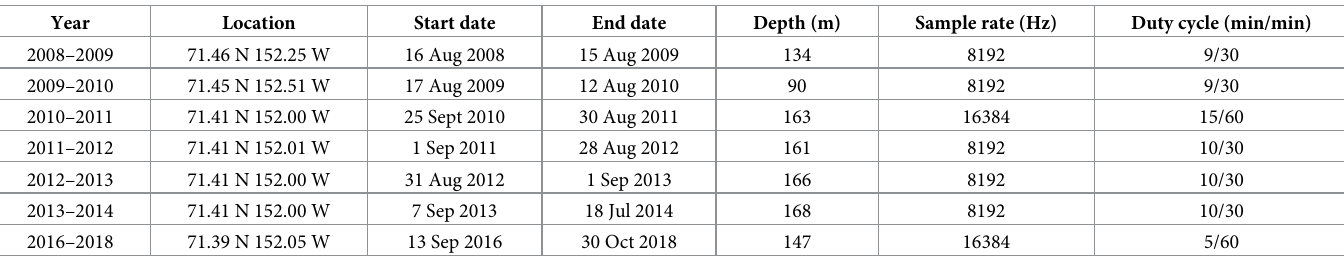
Table 1. Annual deployment details for the hydrophone moored in DBO